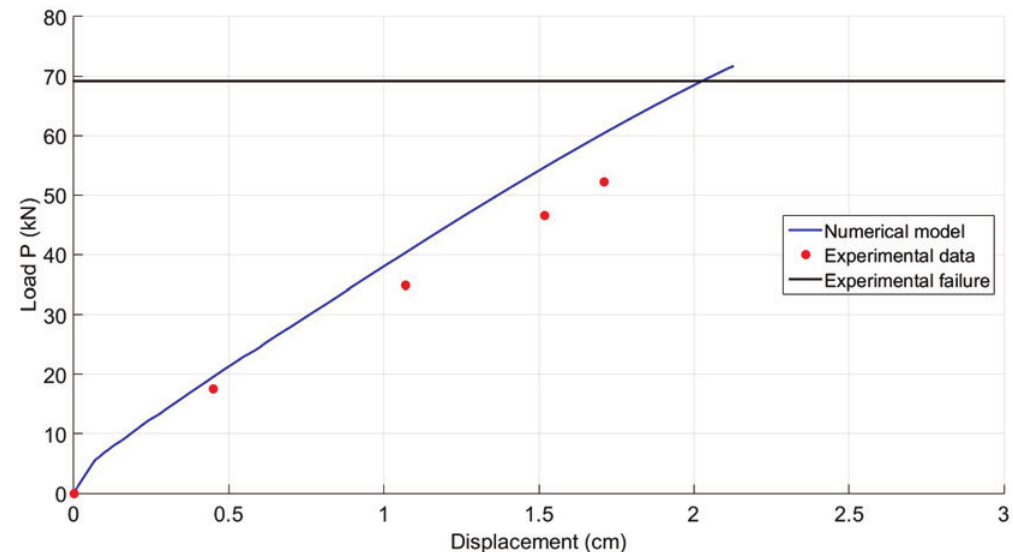
Figure 4.5 Load-displacement plot for the specimen